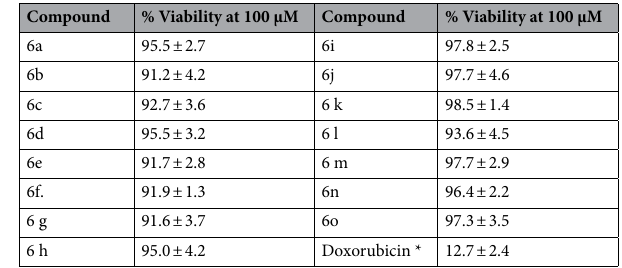
Table 4. The viability percent of MOLT-4 cells after being exposed to thioxothiazolidinyl-acetamide compounds (6a–o). * The results of doxorubicin were reported in the term of IC 50